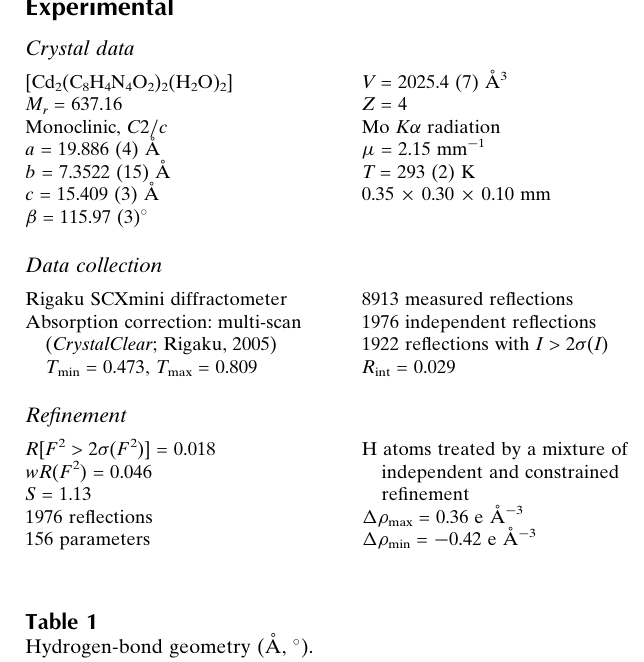
Rigaku SCXmini diffractometer Absorption correction: multi-scan